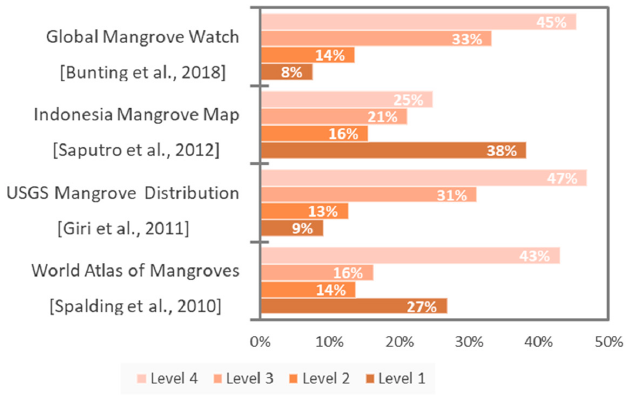
Figure 12. The percentage level of agreement for each mangrove distribution.